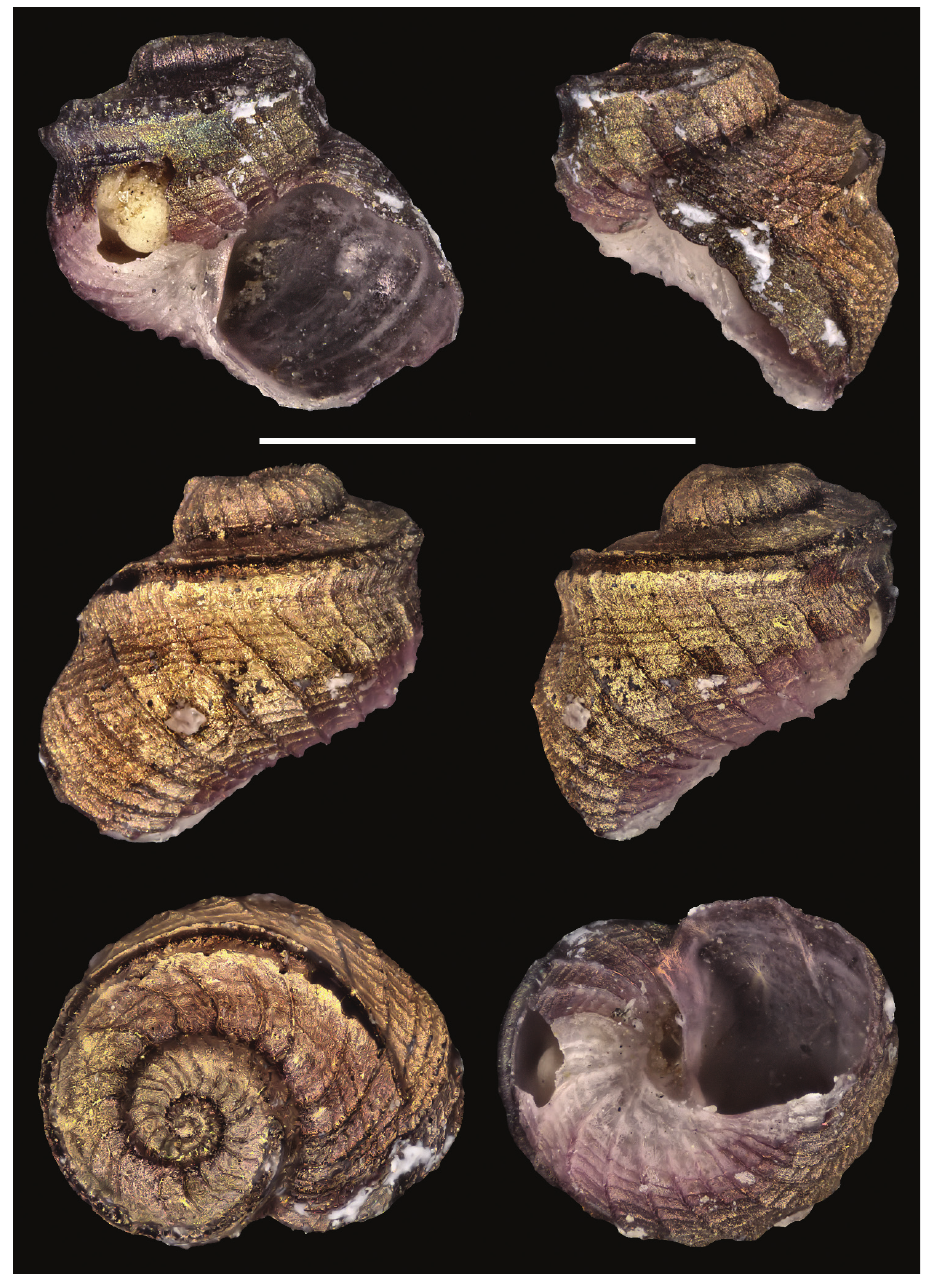
Figure 20. Sinezona doliolum Herbert, 1986. Holotype T3274/NMSA-MOL 0C8471. Scale bar: 1